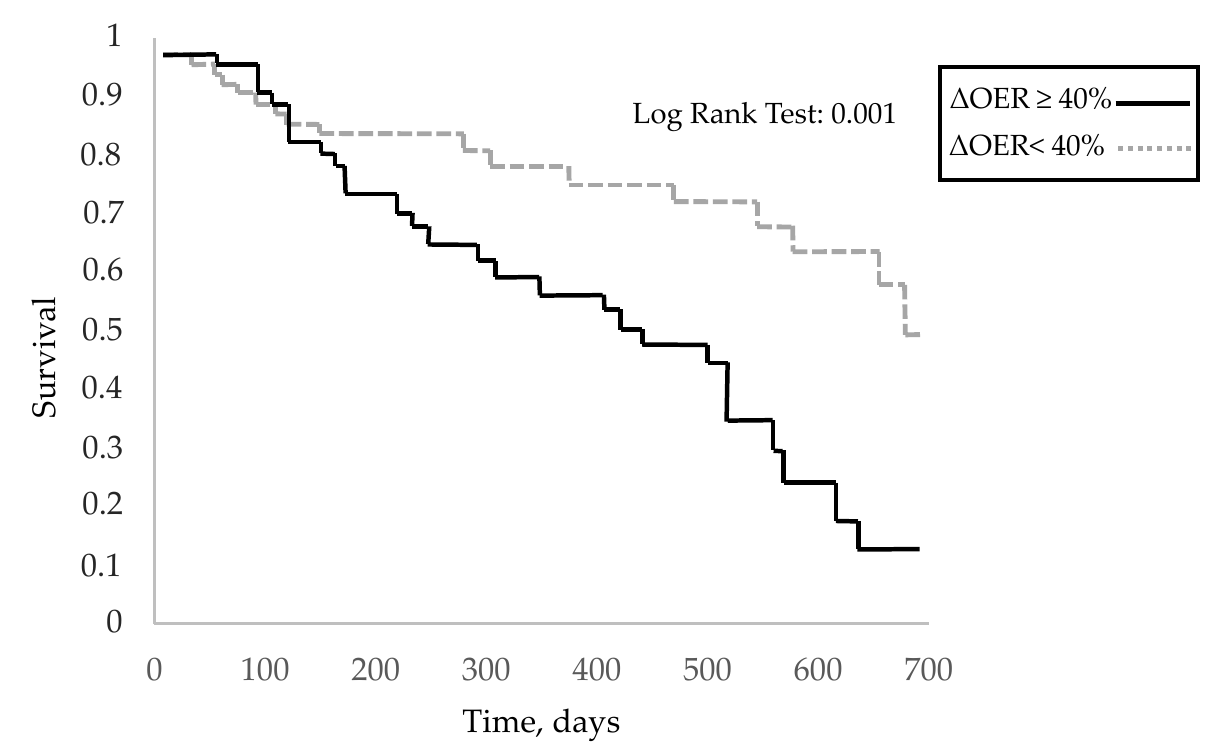
Figure 3. Overall survival, ∆ OER ≥ 40% vs. ∆ OER < 40%. Time 0 was the date of the first haemodial- ysis session after enrolment. Kaplan–Meier log rank test, p = 0.001. OER, oxygen extraction ratio; ∆ OER, variation in OER.